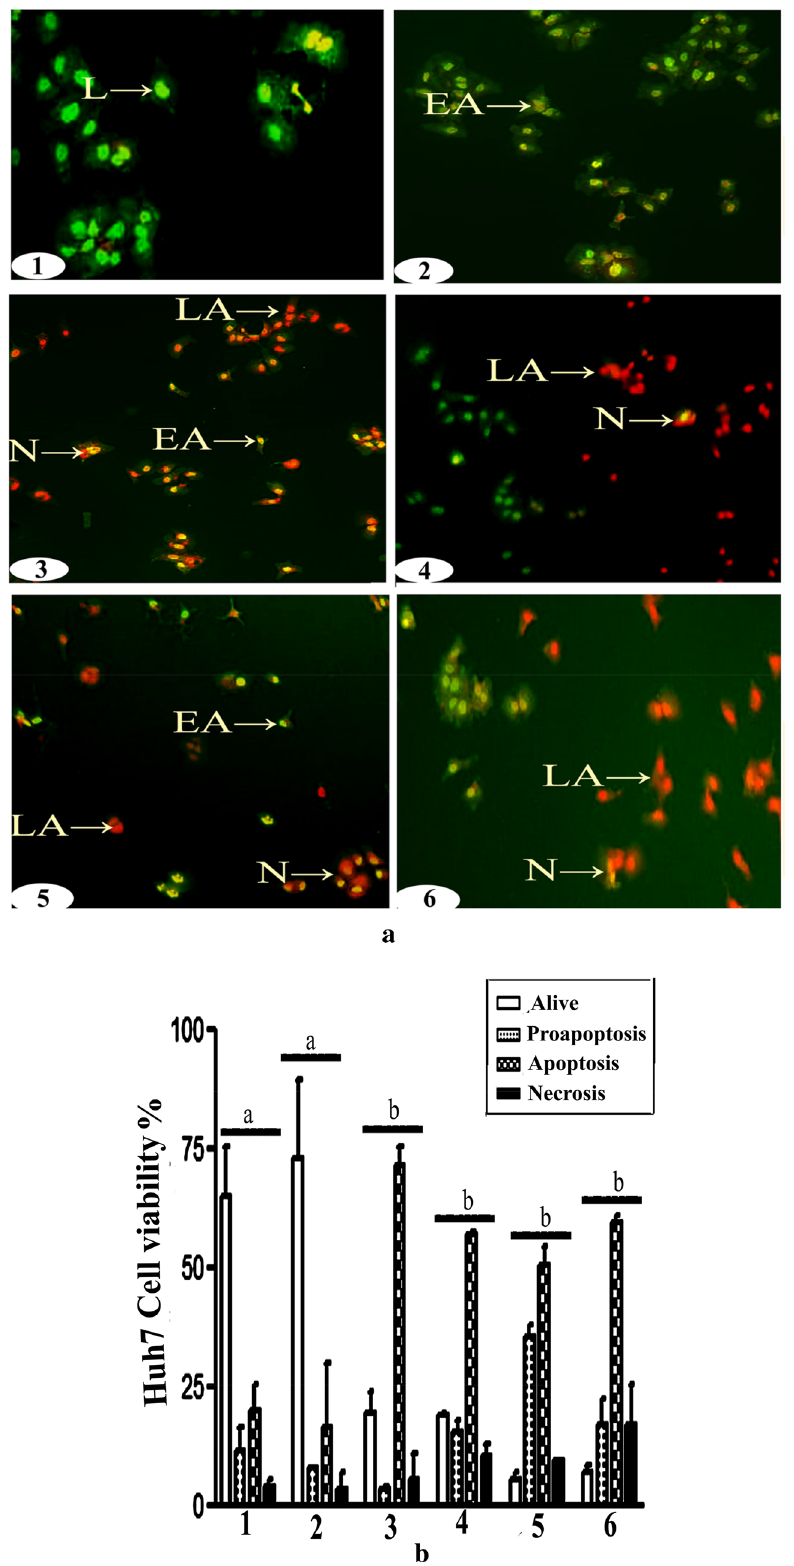
Figure 4. Curcumin and nanocurcumin induced apoptosis of Huh-7 hepatic cancer cells. ( a ) EB/AO staining assay of Huh-7 cells ( 1 = control, 2 = AC, 3 = AC + Cur, 4 = AC + NCur, 5 = Cur, 6 = NCur). X = 200. (b) Results expressed as mean ± SEM. Values in the same column with unlike superscript letters are significantly different at p <